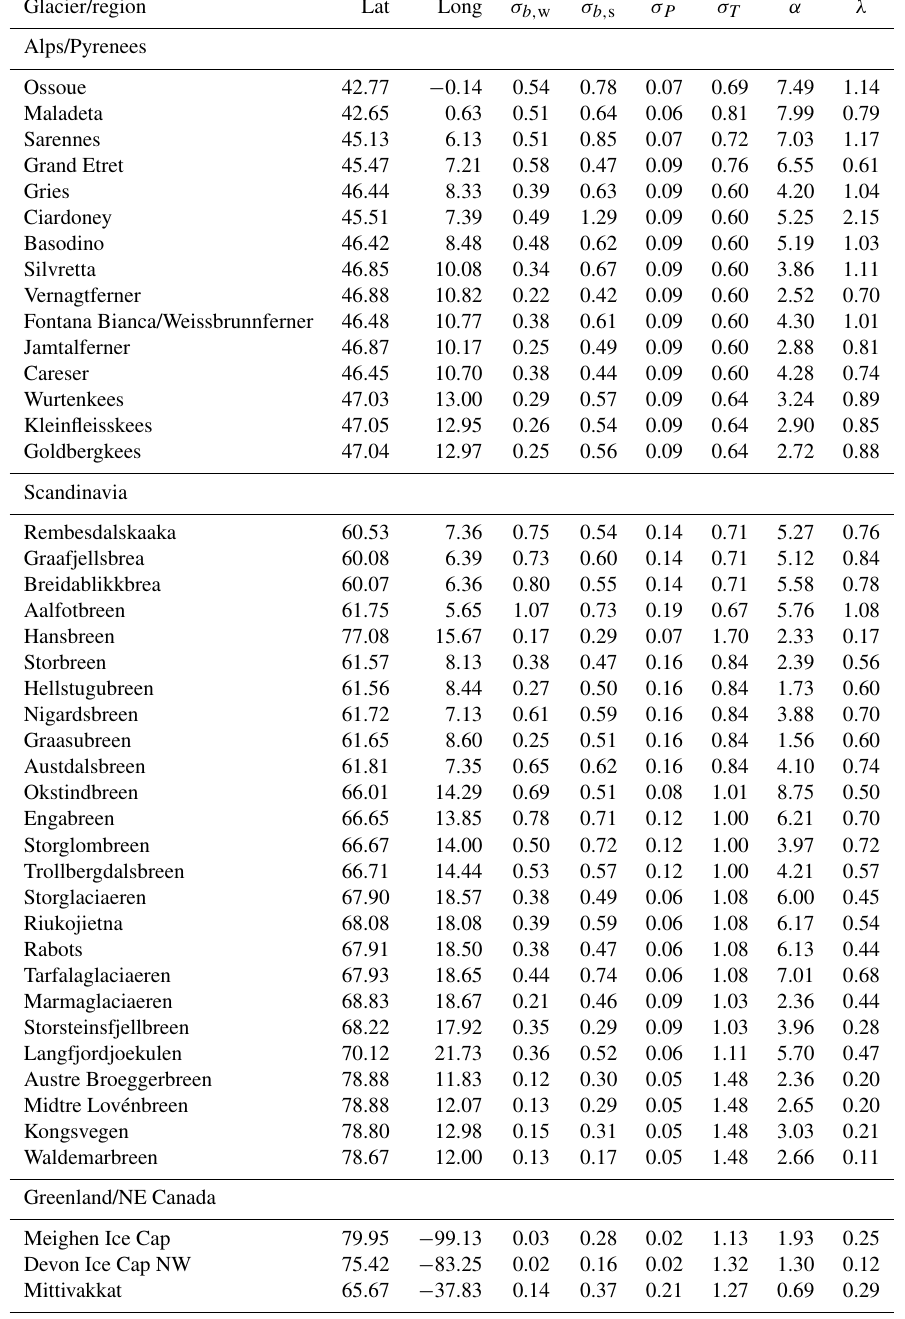
Table A1. Glacier data from Medwedeff and Roe (2017), sorted by region. Glaciers are excluded if observations of summer or winter mass balance span less than 10 years. σ b, w : the standard deviation of observed winter mass balance (in m). σ b, s : the standard deviation of observed summer mass balance (in m). σ P : the standard deviation of simulated winter precipitation within the LME over the last millennium (1000– 1999) (in m). σ T : the standard deviation of simulated summer temperature within the LME over the last millennium (1000–1999) (in K). α : the ratio of σ b, w /σ P . λ : the ratio of σ b, s /σ T (in